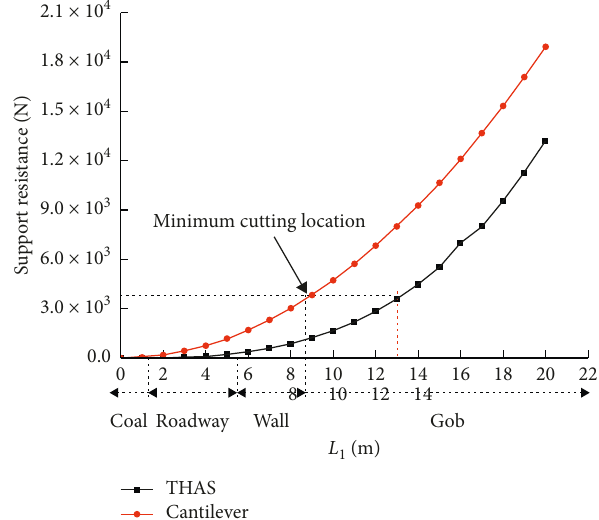
Figure 5: Relationship between the roof cutting and the wall force of different overburden